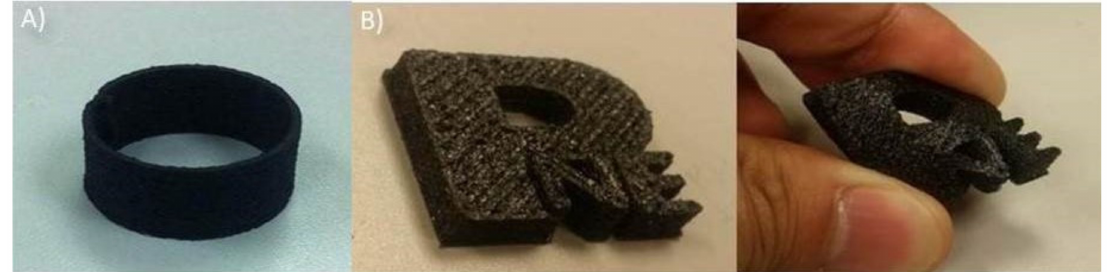
Figure 8. 3D product of TPU / CNT (10 wt %) composites. ( A ) A hollow cylinder, and ( B ) (Printing Nano Engineering (PNE)lab